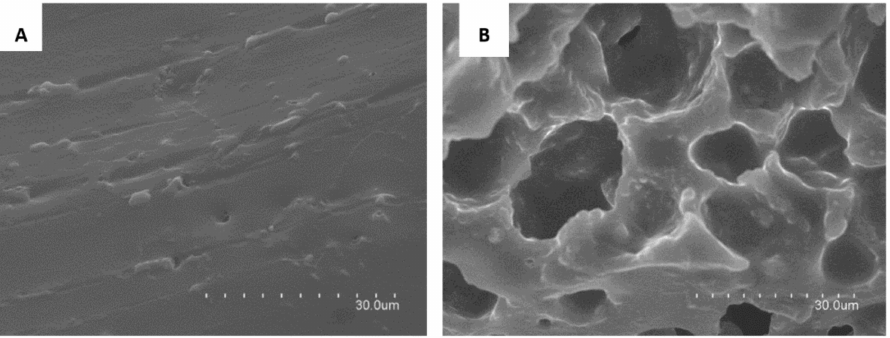
Figure 1. SEM imagens corresponding to the PDMS-TEOS ( A ) and PDMS-OMIM PF 6 ( B ) membranes.